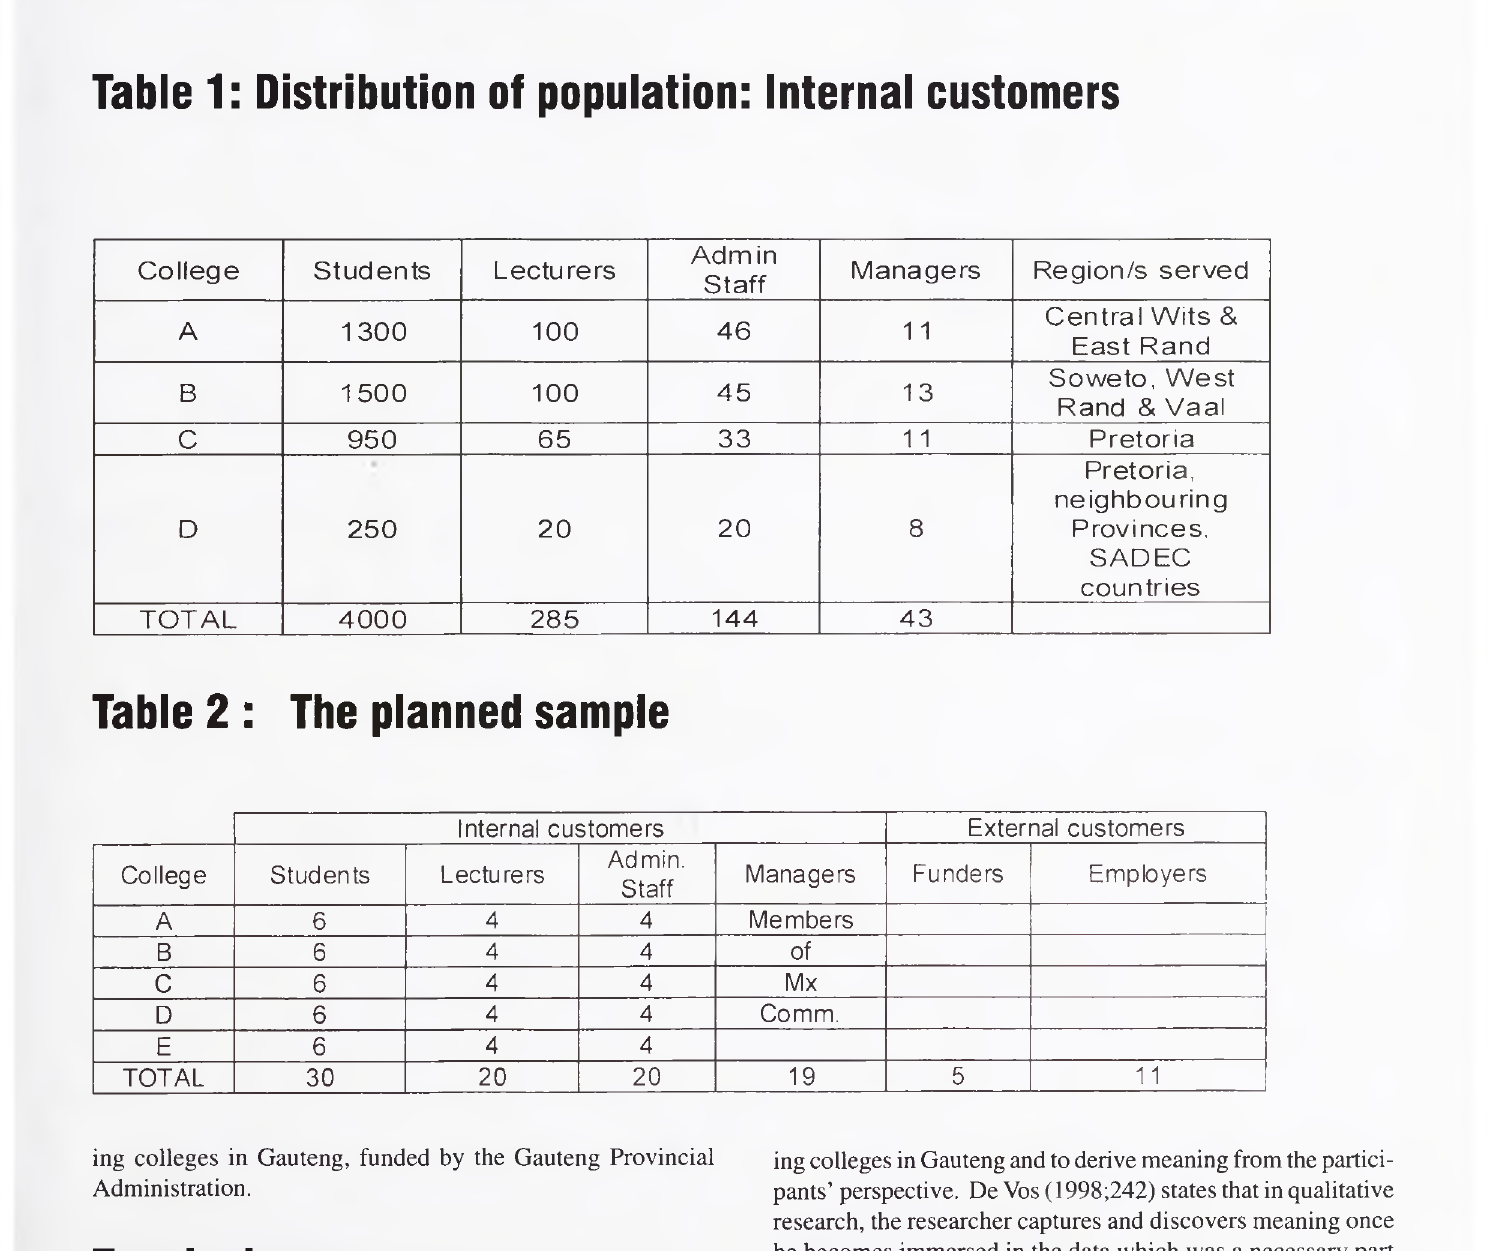
Table 1 : Distribution of population: Internal customers